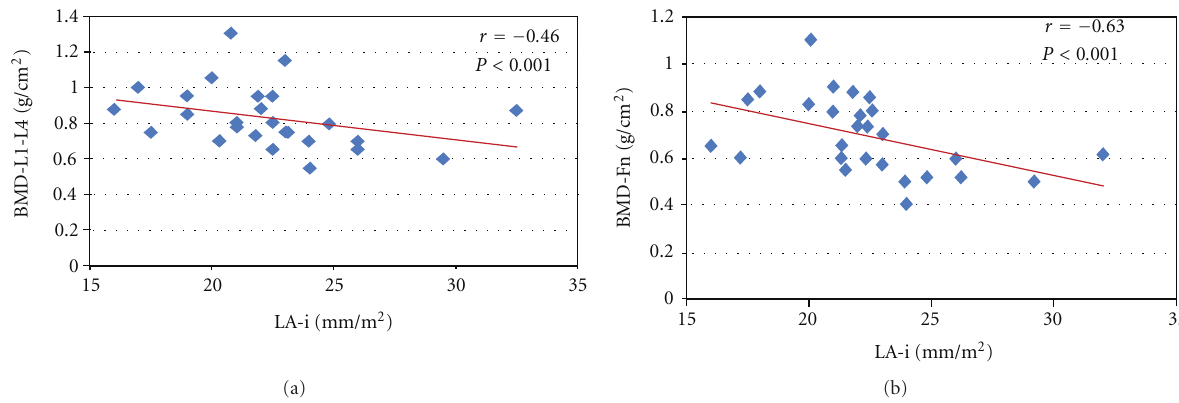
Figure 4: Linear correlation in PHPT patients between left atrium diameter (LAi) and bone mineral density (BMD) at lumbar spine (a) ( r = − 0 . 46; P < 0 . 01) and femoral neck (b) ( r = − 0 . 63; P < 0 . 001).